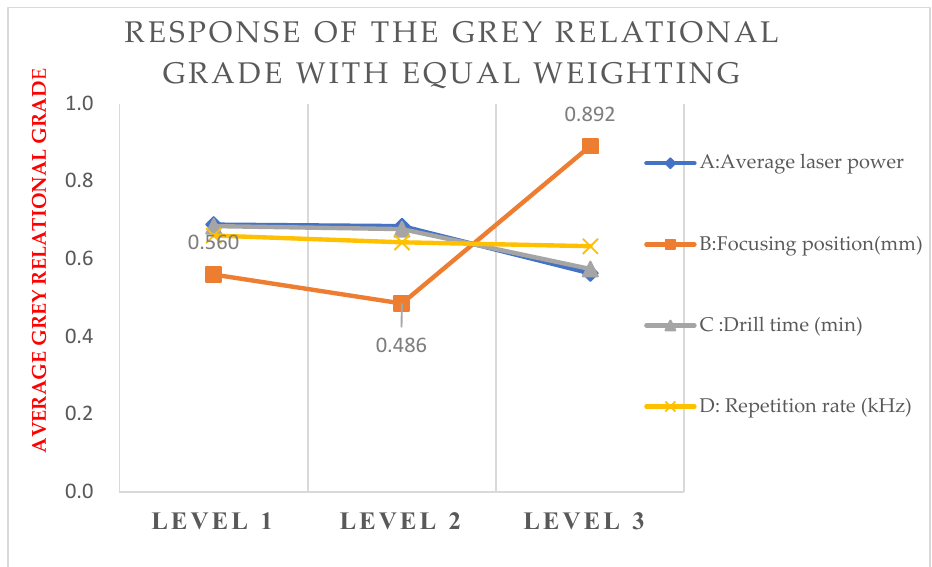
Figure 6. Response of the GRG with equal weighting factors.